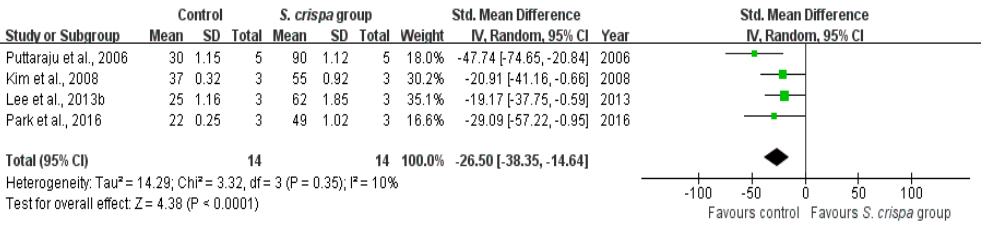
Figure 11. Comparison of DPPH radical scavenging activity between control and S. crispa groups. ( ): SMD of individual studies; ( ): summary SMDs of the comparison.